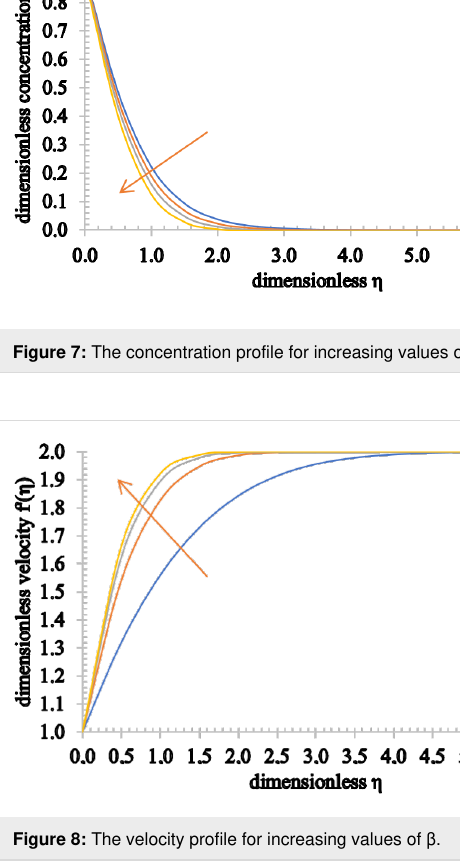
Figure 5: The velocity profile for increasing values of A .